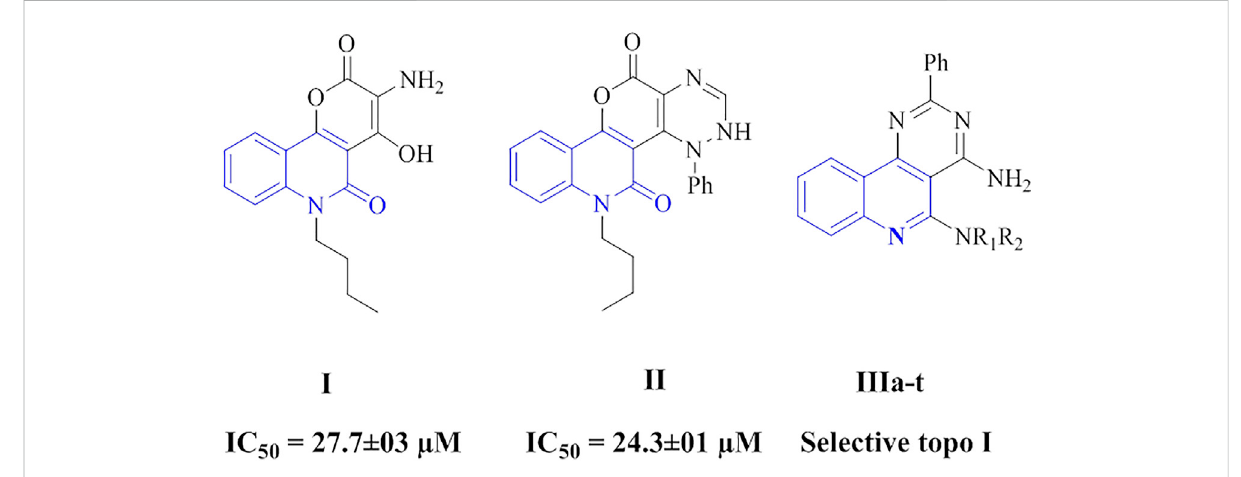
FIGURE 1 Reported quinolones-based compounds targeting topoisomerases.